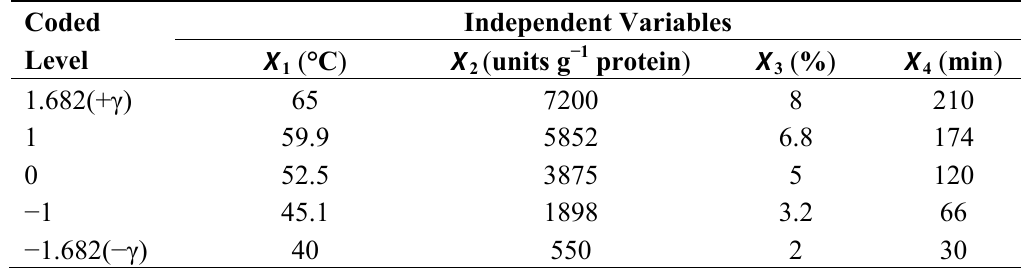
Table 4. Coded settings of the independent variables for DAM hydrolysis, according to central composite rotatable design: hydrolysis temperature (°C) ( X ratio (E/S) (units g − 1 protein) ( X ( X ) were the four independent 4